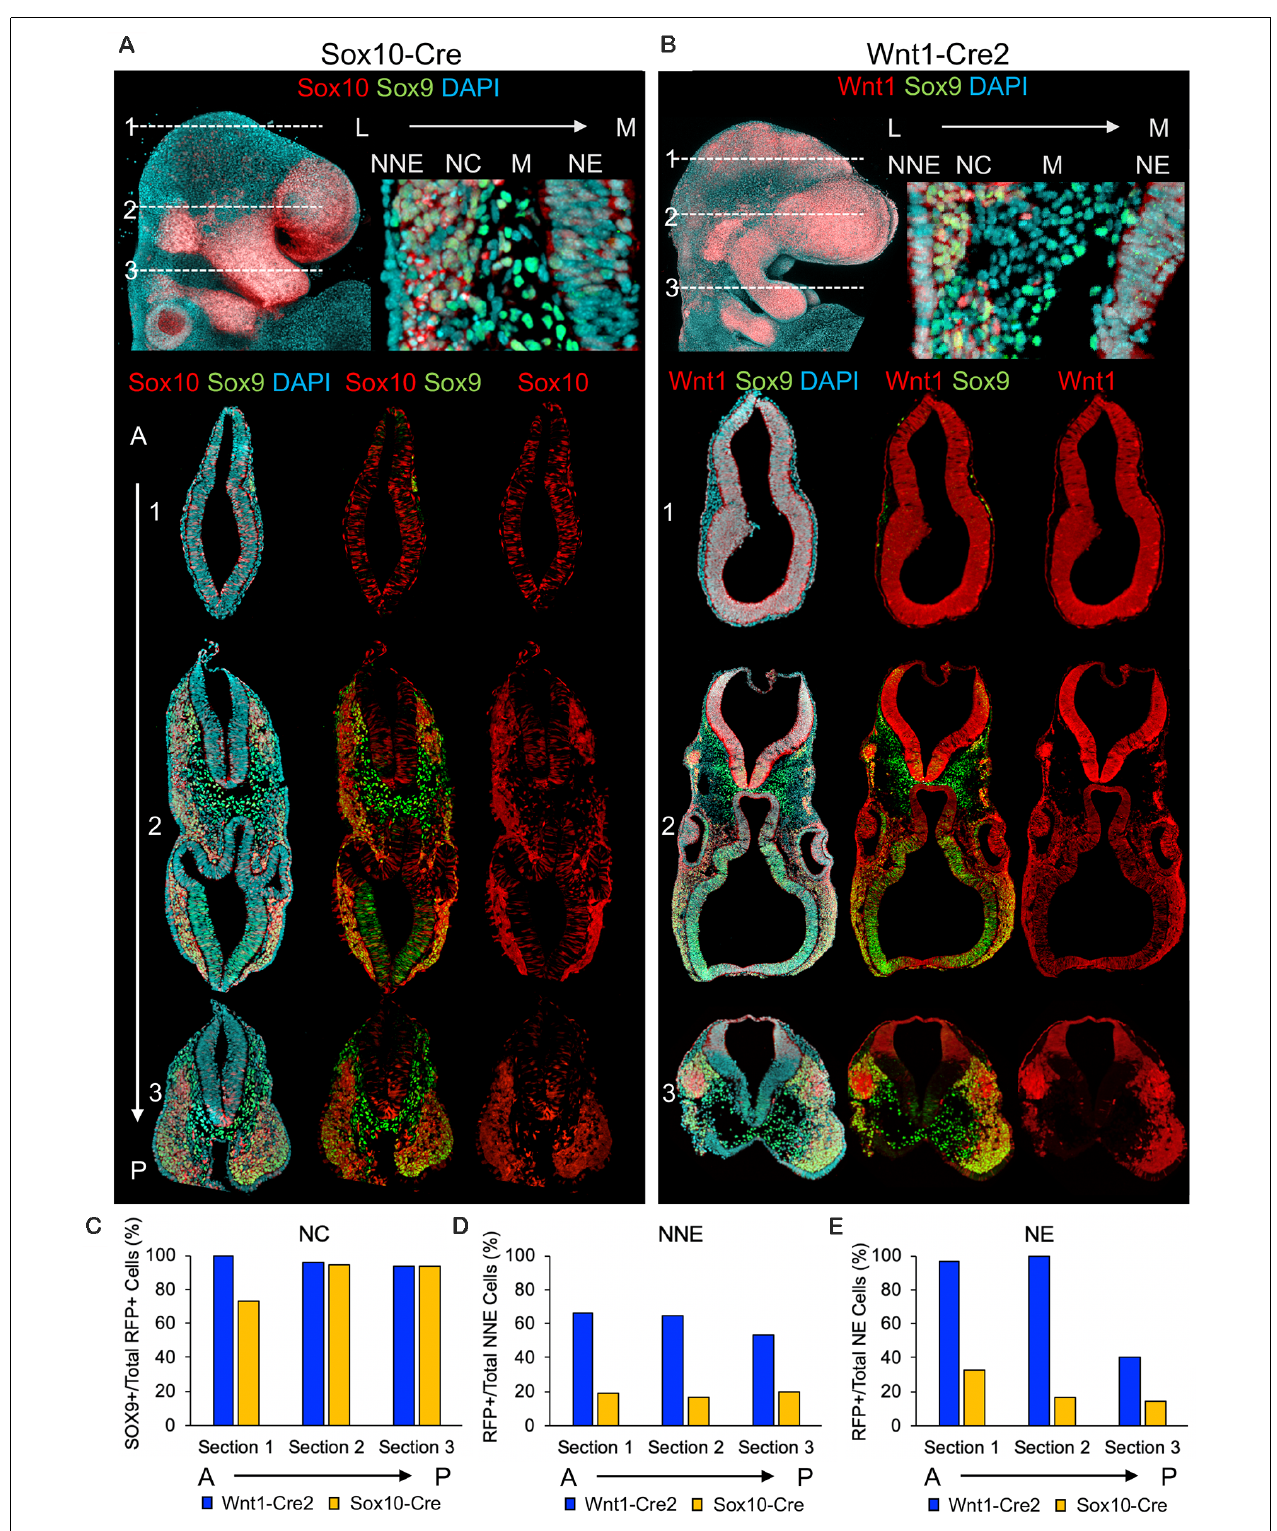
FIGURE 1 | Wnt1-Cre2 and Sox10-Cre label neural crest and cells of the neural tube. (A) Wholemount and sequential transverse cross-sections of embryos in which ROSA26 Tomato/+ embryos were recombined using Sox10-Cre and (B) Wnt1-Cre. Axial positions of transverse cross-sections are noted for each Cre-driver. (C) Quantification of neural crest, (D) non-neural ectoderm and (E) neuroepithelial labeling obtained from Sox10-Cre and Wnt1-Cre.